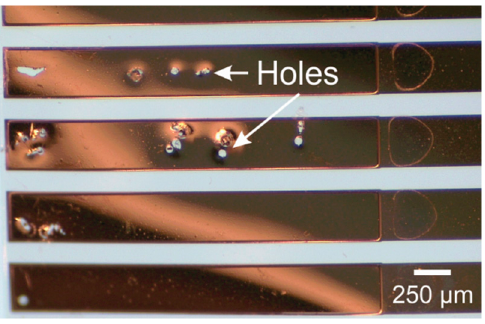
Figure 9. Holes left by gold removal during ultrasonic wire (ball) bonding on a gold thin film on Parylene substrate.